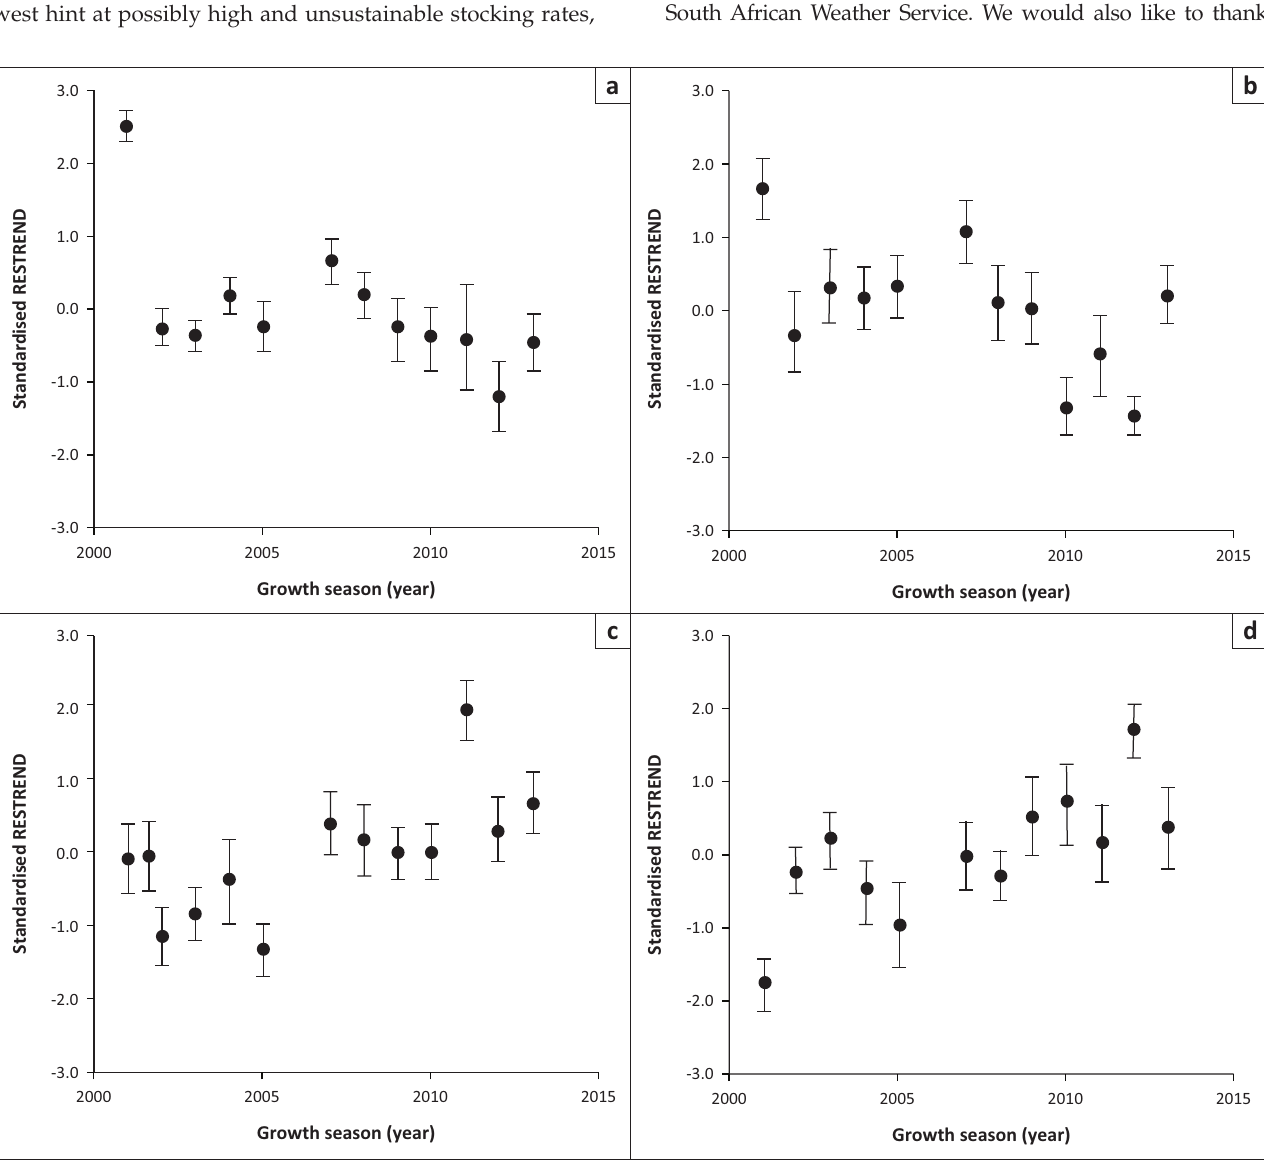
Figure 9 continues on the next page